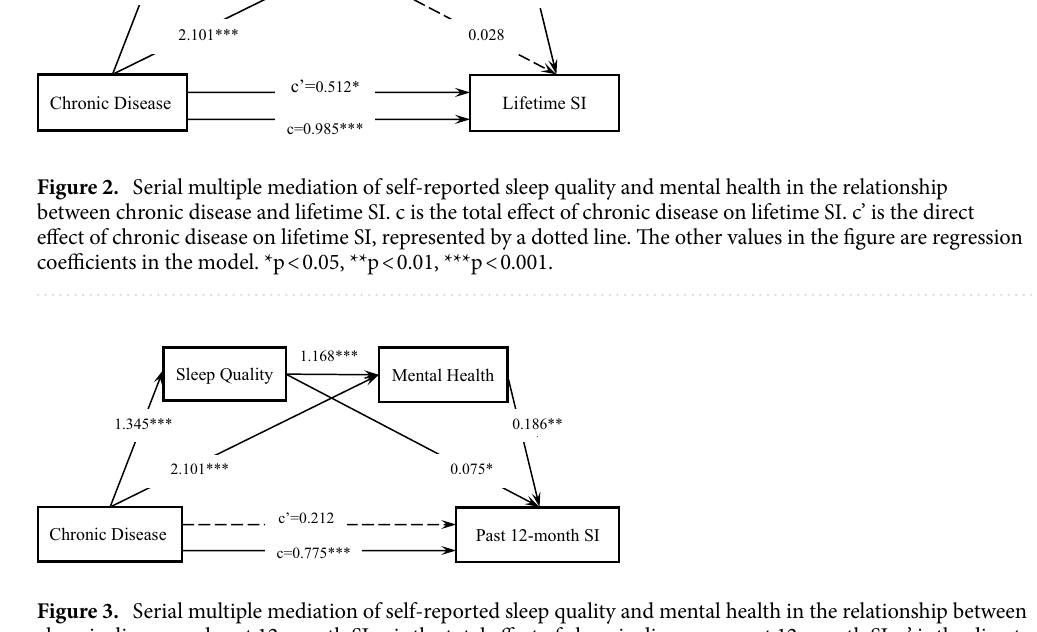
Figure 3. Serial multiple mediation of self-reported sleep quality and mental health in the relationship between chronic disease and past 12-month SI. c is the total effect of chronic disease on past 12-month SI. c’ is the direct effect of chronic disease on past 12-month SI, represented by a dotted line. The other values in the figure are regression coefficients in the model. *p < 0.05, **p < 0.01, ***p <